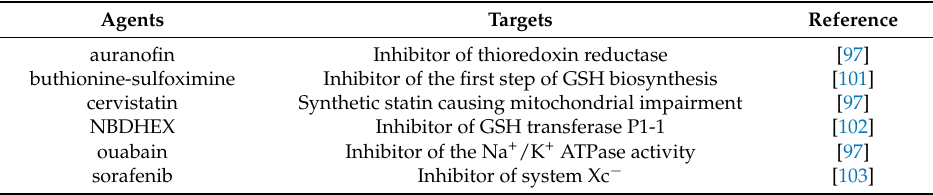
Table 3. Oxidative stress inducers that have shown efficacy in RMS